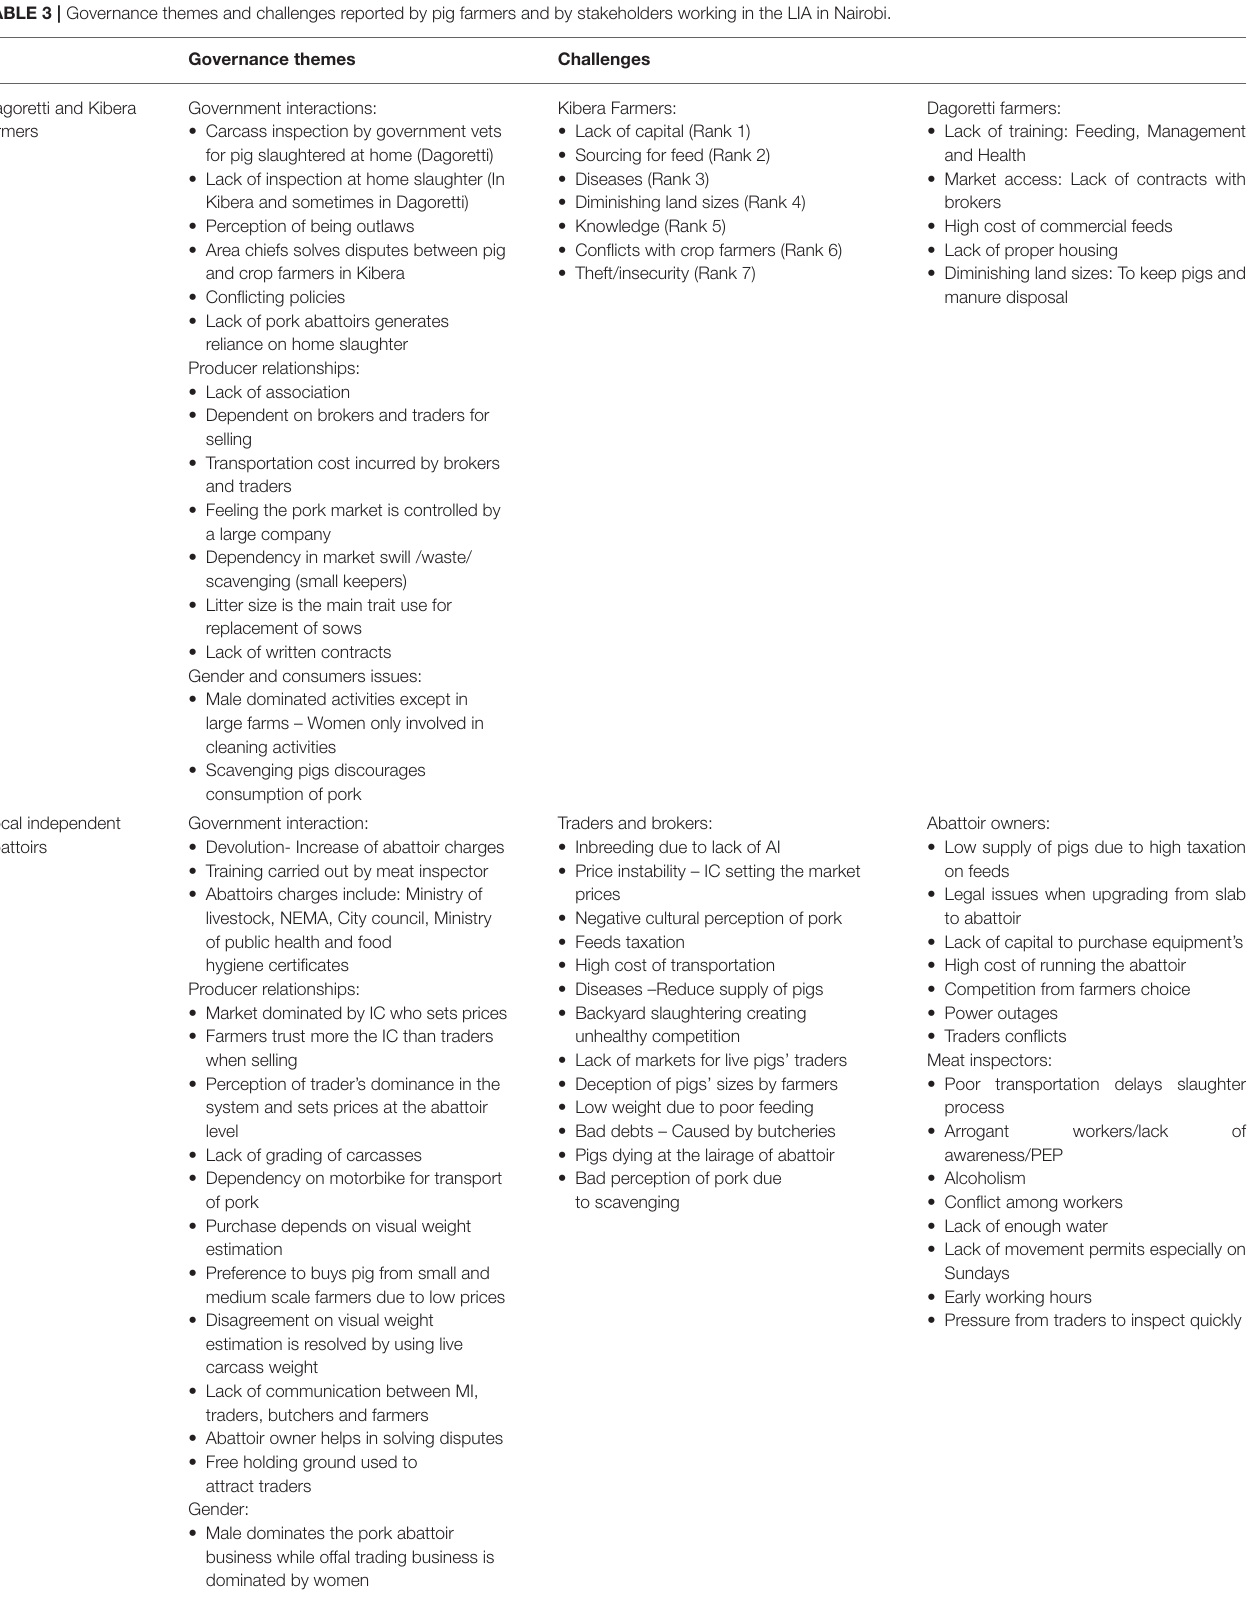
TABLE 3 | Governance themes and challenges reported by pig farmers and by stakeholders working in the LIA in